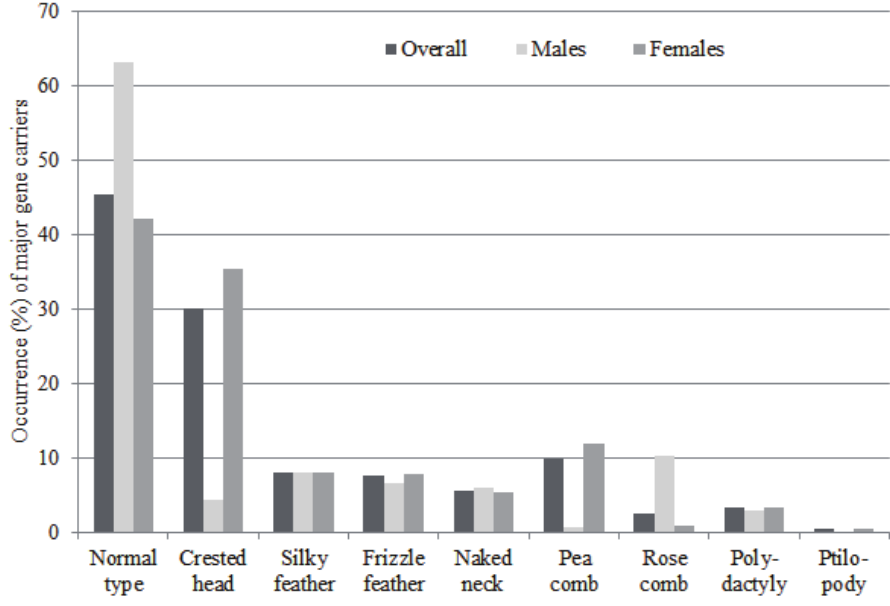
Figure 1. Occurrence (%) of major gene carriers in local chickens. Total n = 788, female chickens n = 652, male chickens n = 136. Some individuals were carriers of several major genes; therefore, percentages do not equal 100. Normal type: Individuals that carried none of the studied major genes. X 2 statistics for differences between male and female chickens: 0.058 for naked neck, 0.232 for frizzle feather, 0.000 for silky feather, 0.628 for ptilopody, 1.277 for polydactyly; all p>0.05, 51.479 for crested head, 39.972 for rose comb, 15.474 for pea comb, 23.086 for normal type; all p<0.001.